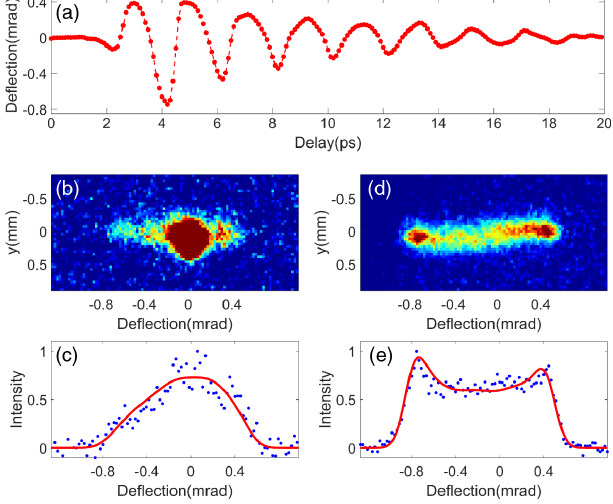
FIG. 4. Time-stamping of the compressed beam. (a) THz streaking deflectogram measured as a function of time delay (in 100 fs steps) between the electron beam and THz pulse. Raw distribution of the streaked beam with passive bunching tech- nique (b) and fitting to the timing data (c). Raw distribution of the streaked beam with active bunching technique (d) and fitting to the timing data